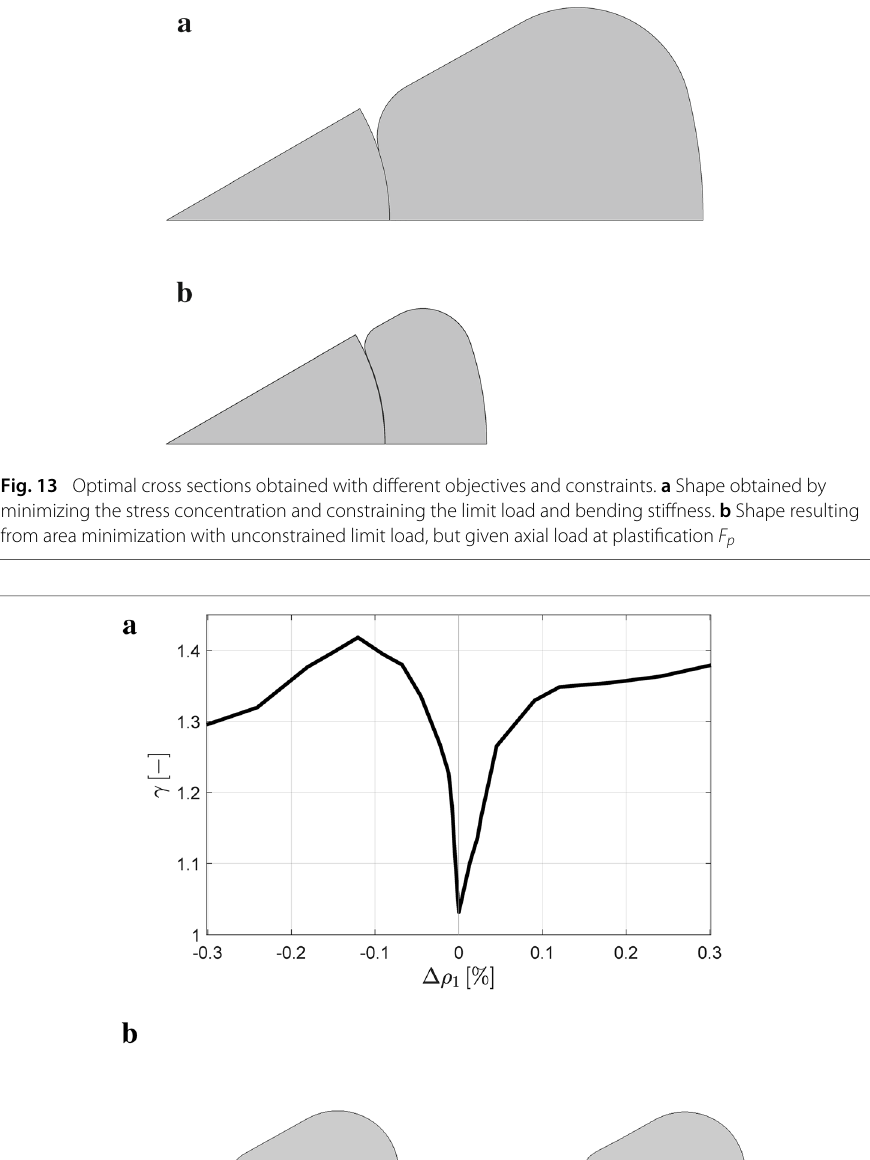
the 37% of the reference strand area ( A = 28 . 9 mm 2 ). A delayed plastification‘ start can provide margin for reducing the safety factor and consequently the required